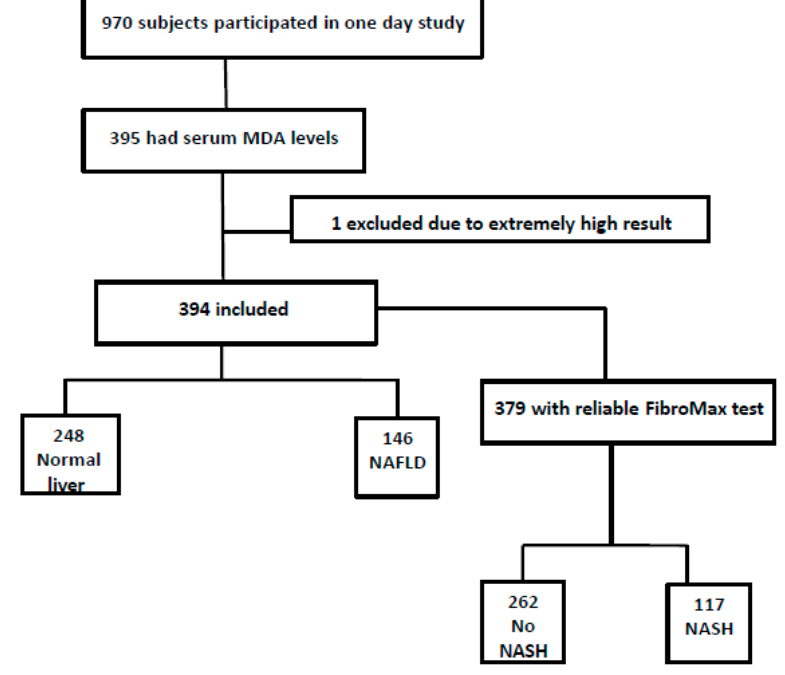
Figure 1. Flow chart of study population.